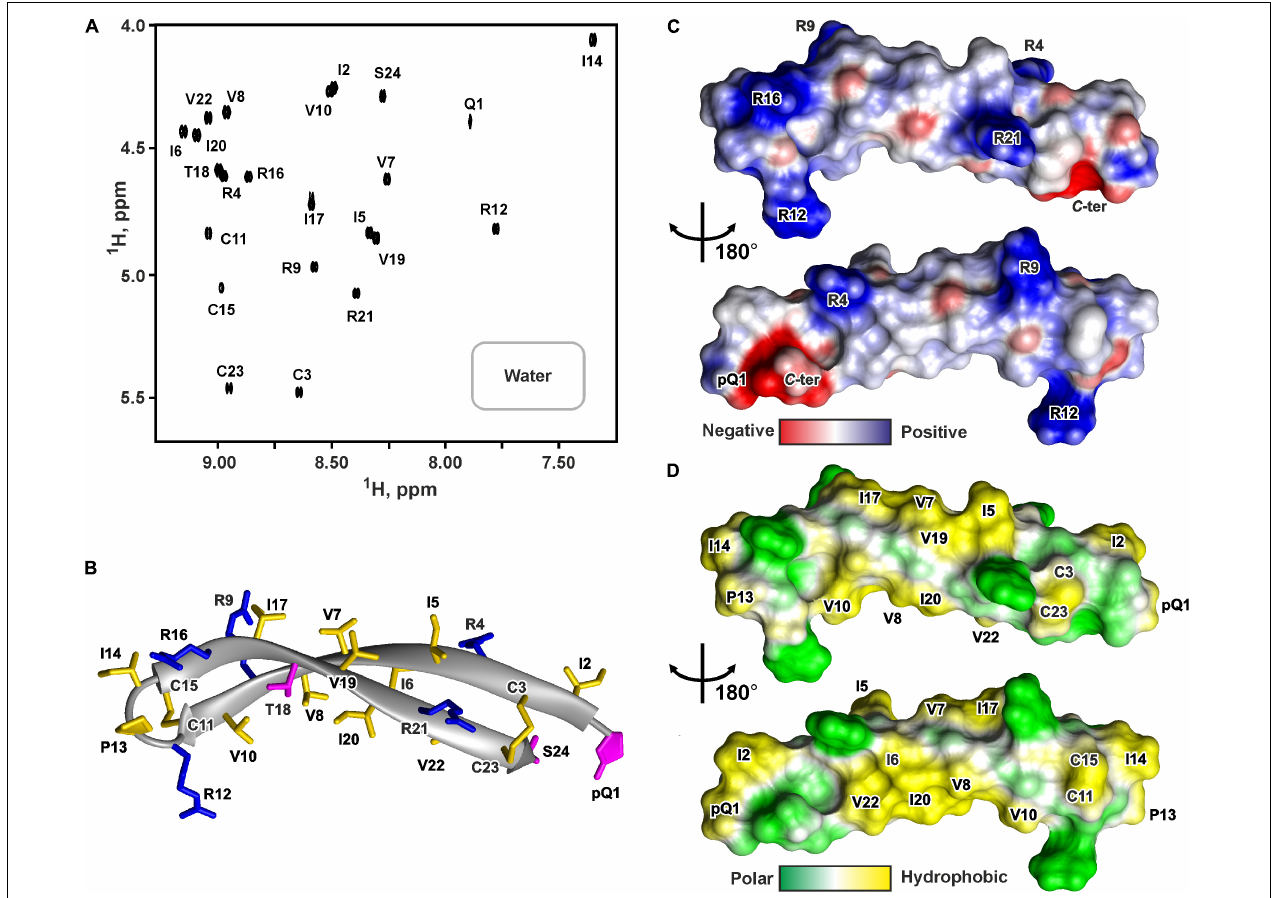
FIGURE 5 | NMR data defines 3D structure of PcDode. (A) 2D 1 H-TOCSY spectrum (mixing time – 80 ms) of 0.6 mM PcDode in water (pH 4.4, 30 ◦ C, 600 MHz, 8,192 × 600 data points, 18 ppm × 11 ppm spectral width). The obtained resonance assignments are shown. (B) The representative conformer of PcDode in ribbon representation. The positively charged and polar residues are colored in blue and magenta, respectively. Disulfide bonds and hydrophobic residues are colored in yellow. Electrostatic (C) and molecular hydrophobicity (Pyrkov et al., 2009) (D) potentials are shown on the molecular surfaces of the PcDode. Red, blue, green, and yellow areas denote negative, positive, polar, and hydrophobic regions,